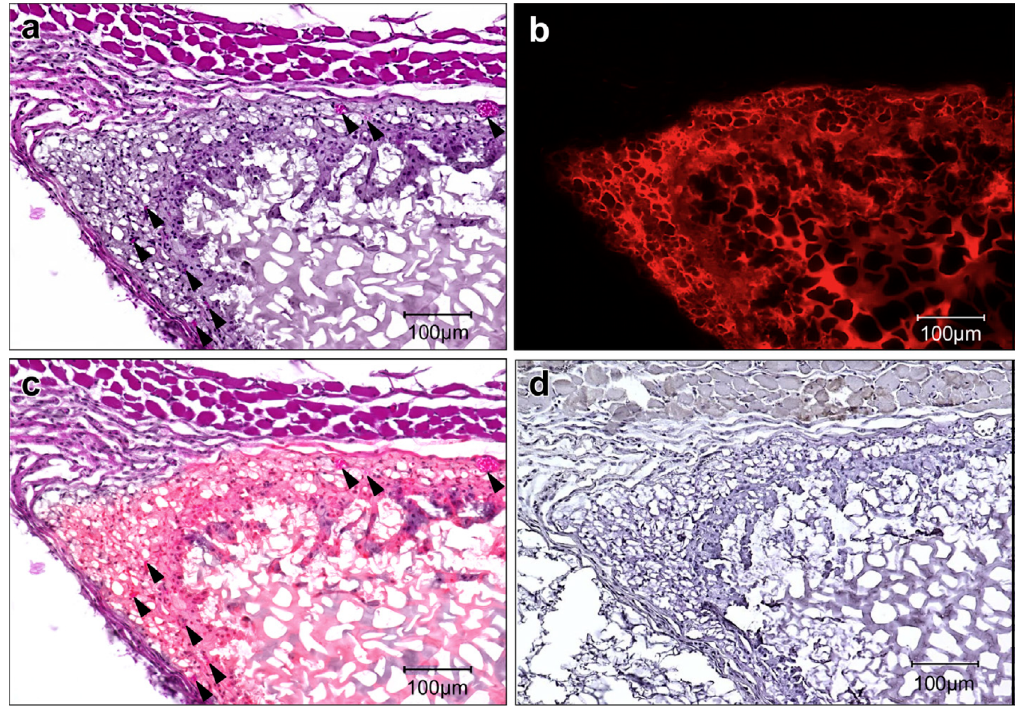
Figure 3. Histology of subcutaneously implanted NanoCliP gel in mice. ( a ) H&E staining of the NanoCliP gel 4 weeks after transplantation. Arrows indicate the newly formed vessels in the NanoCliP gel. ( b ) The confocal LSM image of the rhodamine-labeled NanoCliP gel confirms that the NanoCliP gel has remained in situ. ( c ) Superimposed image of a and b shows the region containing the remaining NanoCliP gel. ( d ) F4 / 80 staining shows no monocytes and macrophages in or around the transplanted NanoCliP gel. Scale bar ¼ 100 mm: with permission from [159]. Copyright 2020 Elsevier.